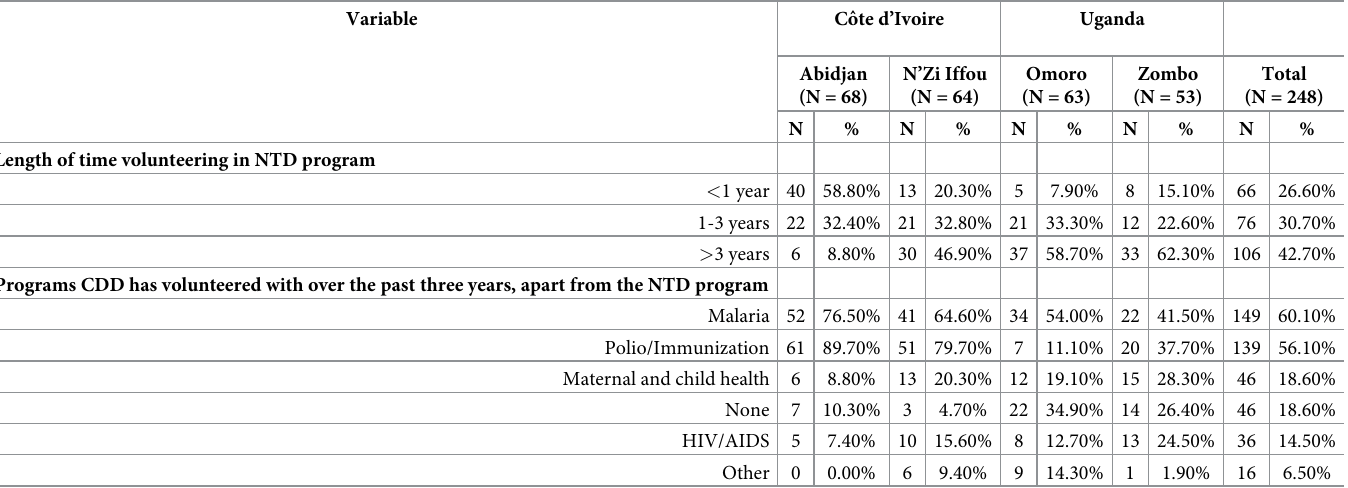
Table 3. Indicators of CDD volunteerism, by region/district.